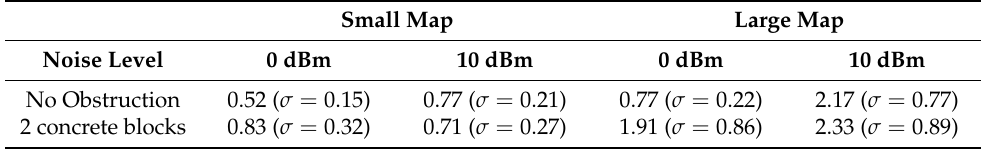
Table 3. Particle filtered location prediction errors in